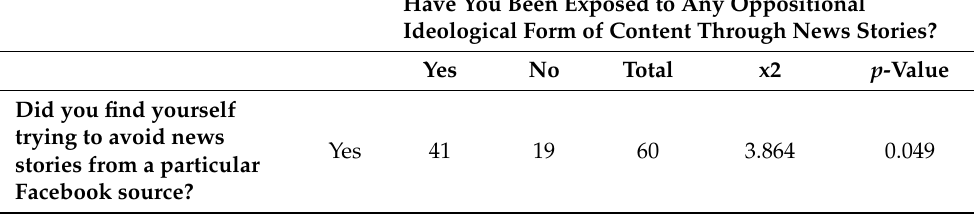
Table 9. Chi-square test analysis of the association between responses to the two questions “Did you find yourself trying to avoid news stories from a particular Facebook source?” and “Have you been exposed to an oppositional ideological form of content through news media